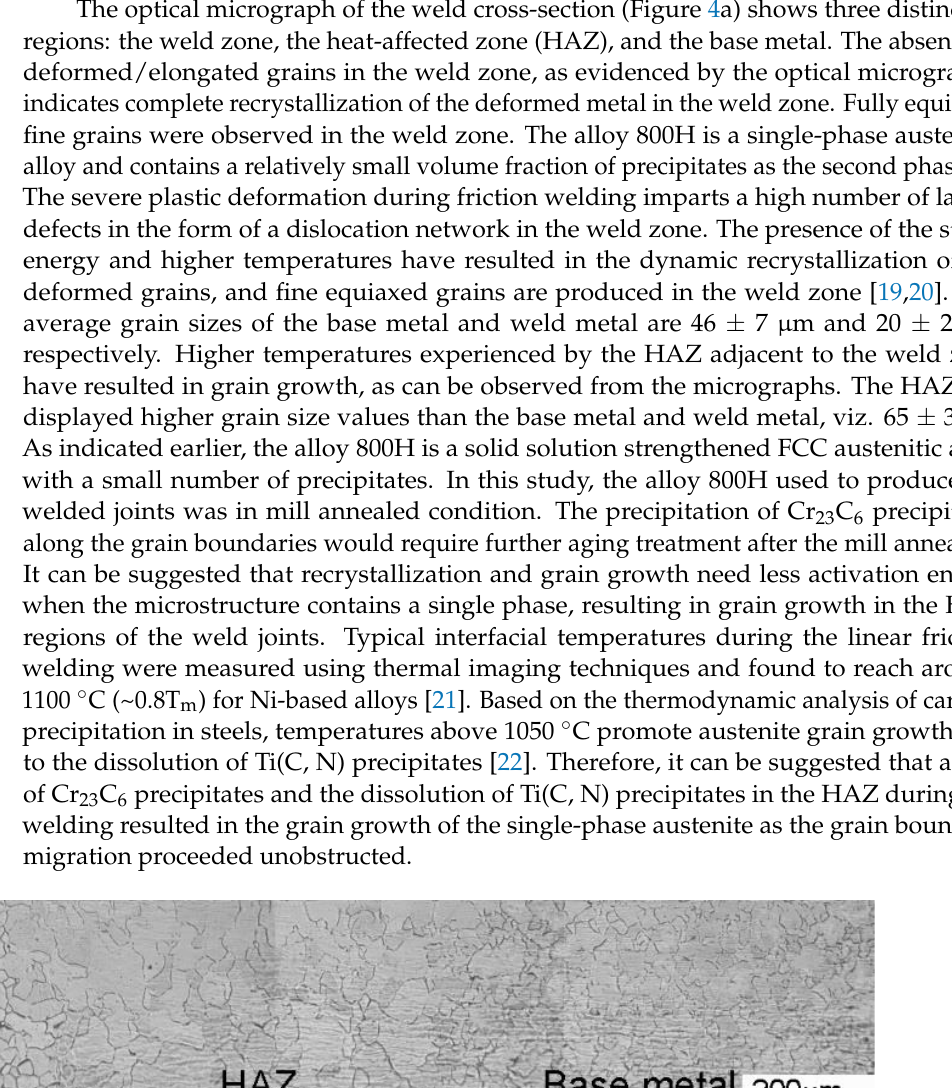
Figure 3. ( a ) The visual view of an Alloy 800H friction weld joint; ( b ) Macrograph of the friction